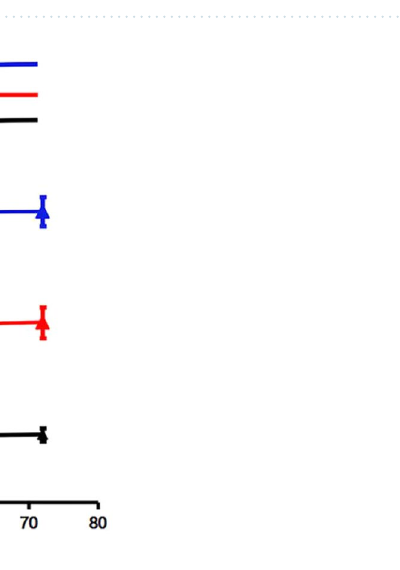
Figure 5. ( A ) The standard curve of DOX. ( B ) The loading rate of DOX on NGO in different concentration of DOX.